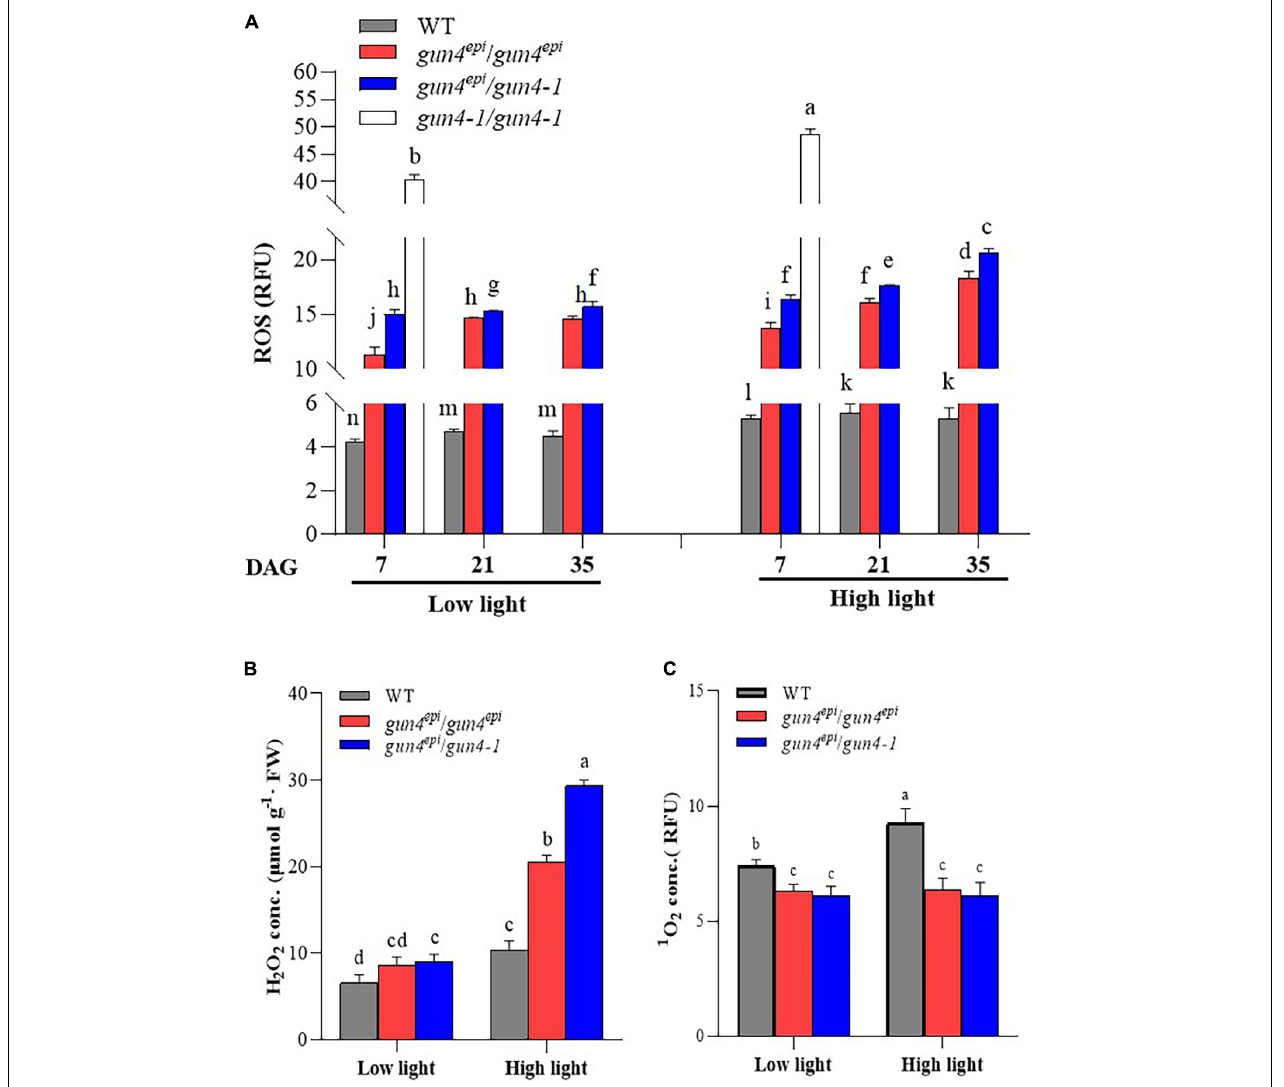
FIGURE 4 | Effects of high light on the accumulation of reactive oxygen species (ROS) in the OsGUN4 mutants. (A) The total reactive oxygen species (ROS) at 7, 21, and 35 days after germination (DAG), as well as concentrations of (B) hydrogen peroxide (H 2 O 2 ) and (C) singlet oxygen ( 1 O 2 ) in rice seedlings at 35 DAG. WT, wild-type variety Longtepu B, gun4 epi / gun4 epi and gun4 epi / gun4-1 are F 2 seedlings derived from the gun4 epi / gun4-1 F 1 plants. The data were analyzed with two-way ANOVA followed by the Tukey’s multiple comparison test, P < 0.05. For the background information of the F 1 plants, see Supplementary Figure 1 .